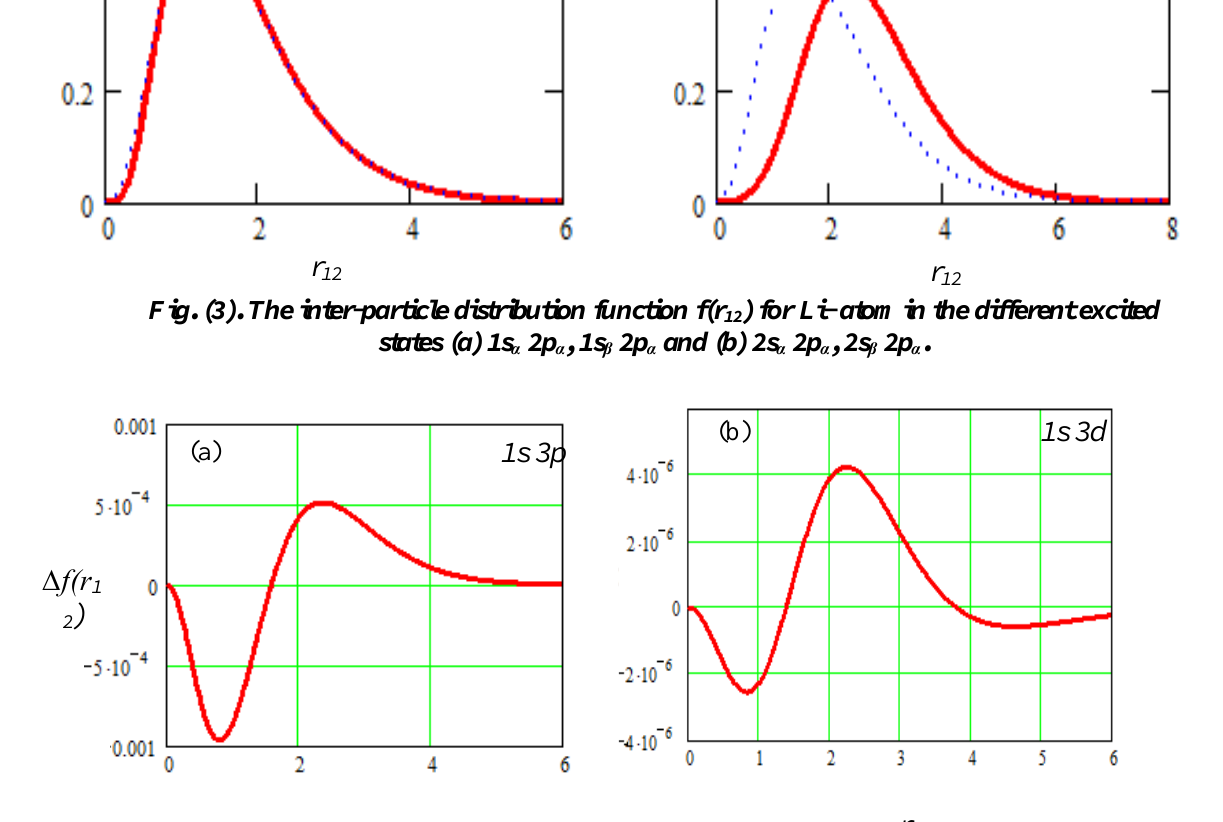
(r12)-f (r12) for Li- atom in different αα βα